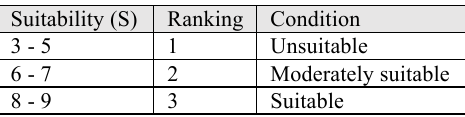
Table 6: Ranking of the Suitability results